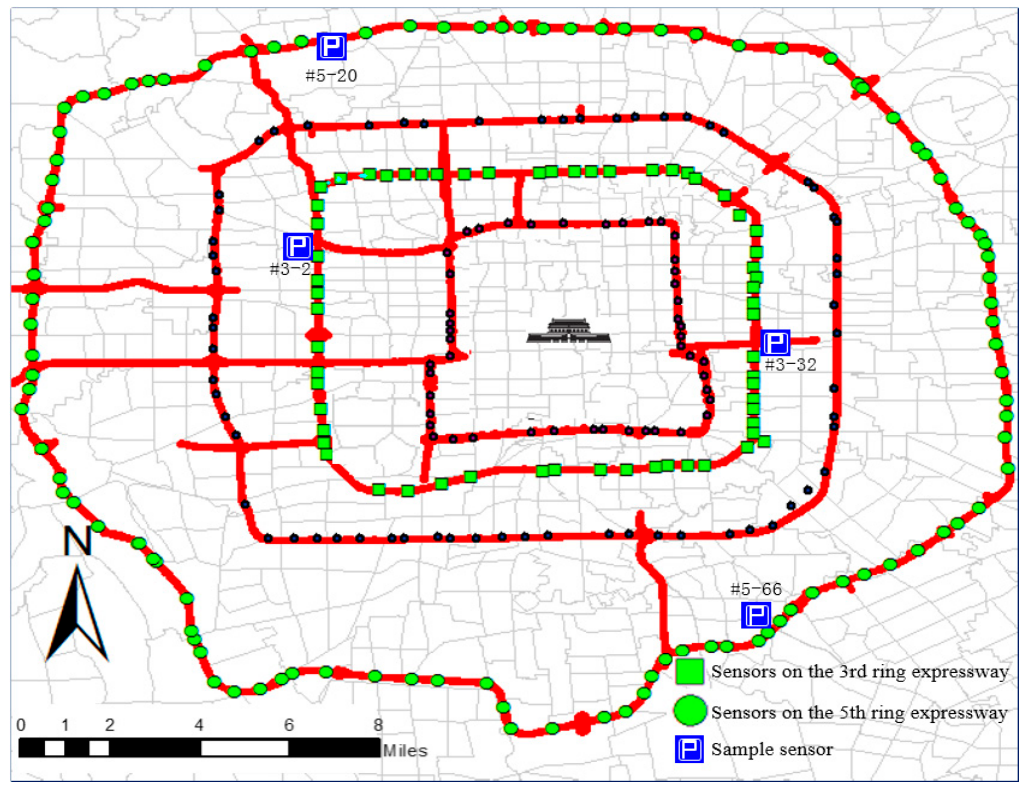
Figure 1. Deployment of microwave sensors on Beijing ring expressways.